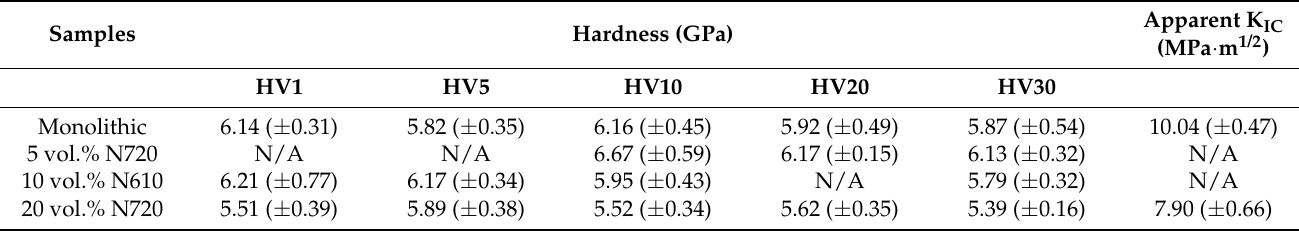
Table 1. Vickers hardness of powder bed sintered monolithic and Al 2 O 3 fiber-reinforced Ti 2 AlC composites. Vickers hardness is given for loads of 1, 5, 10, 20 and 30 kgf. Blank values for HV1, 5 and 20 are account of non-pyramidal